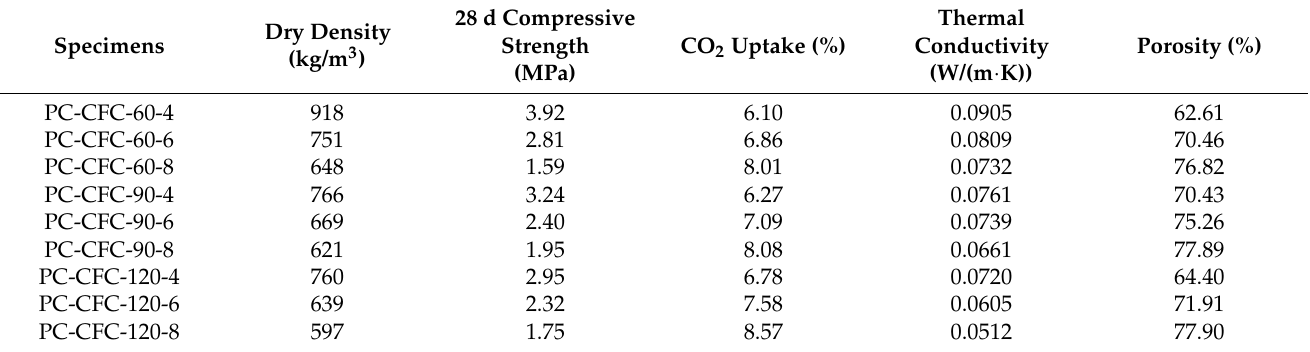
Table 4. Test results of